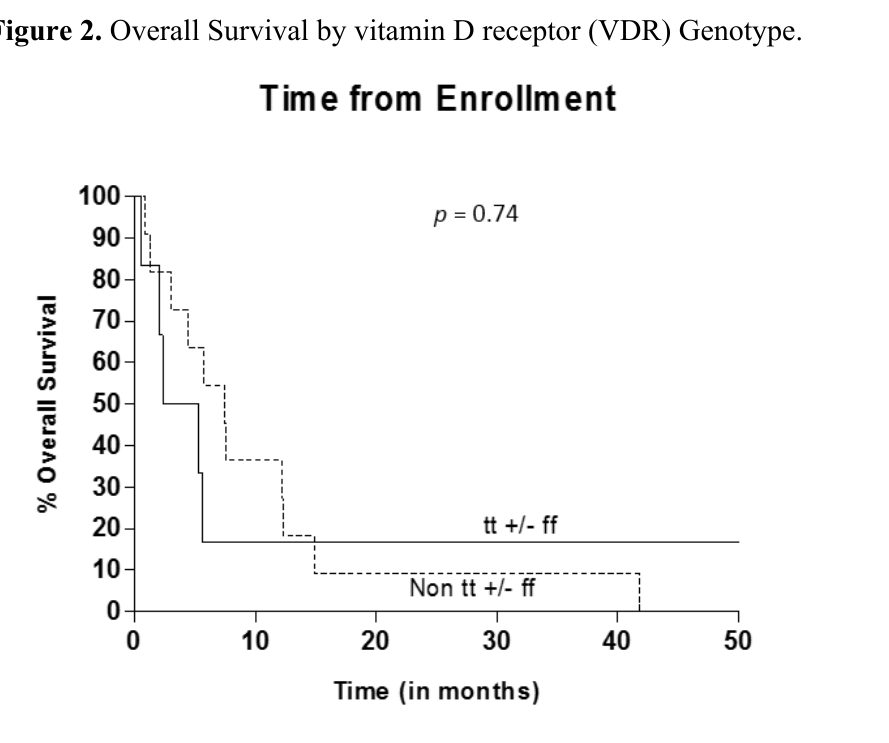
Figure 2. Overall Survival by vitamin D receptor (VDR)